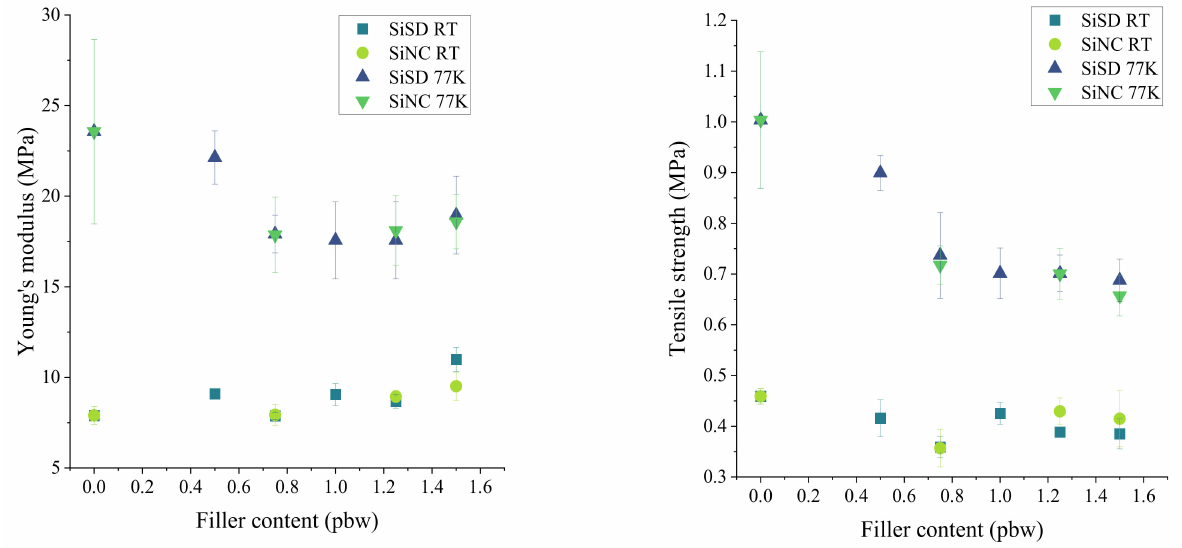
Figure 15. Tensile (Young’s) modulus ( left ) and strength ( right ) of PP40 composites with 0.5–1.25% filler concentration at RT and 77 K.